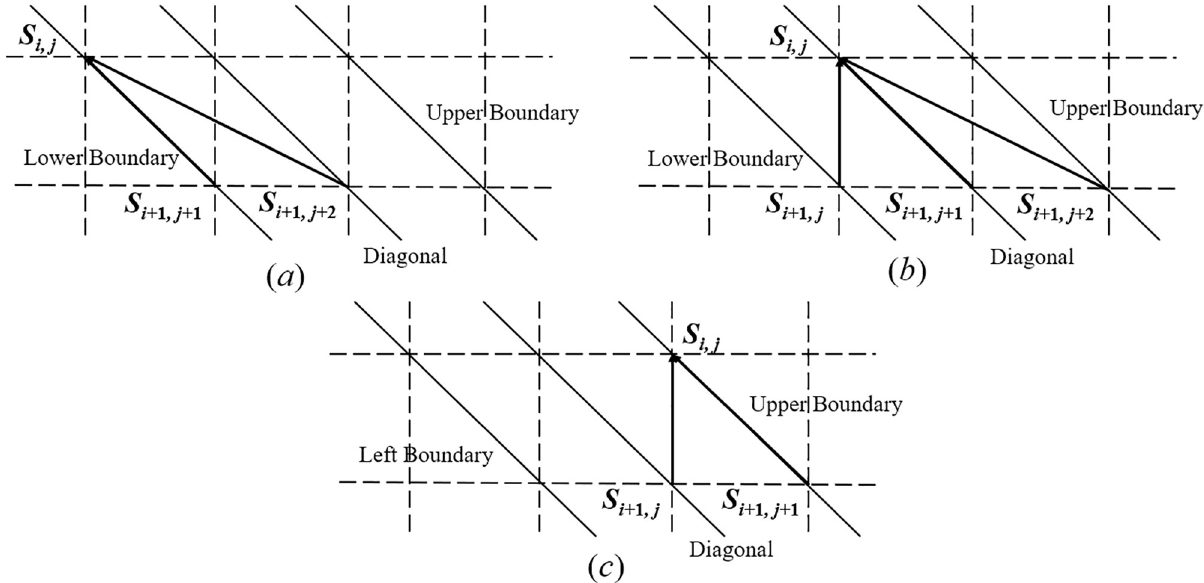
Fig 6. Possible state transitions when x j is located on the diagonal ( j − i = 0); (c) S i , j is located on the upper boundary ( j − i = 1).